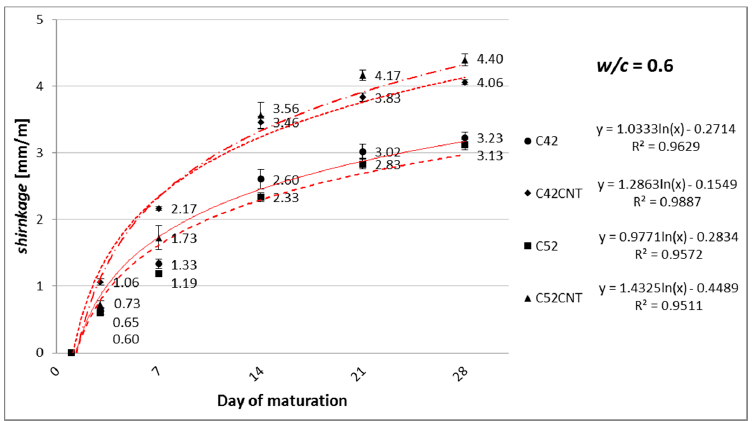
Figure 7. Increase in linear shrinkage of modified cement paste with w / c = 0.6, as a function of maturation time.